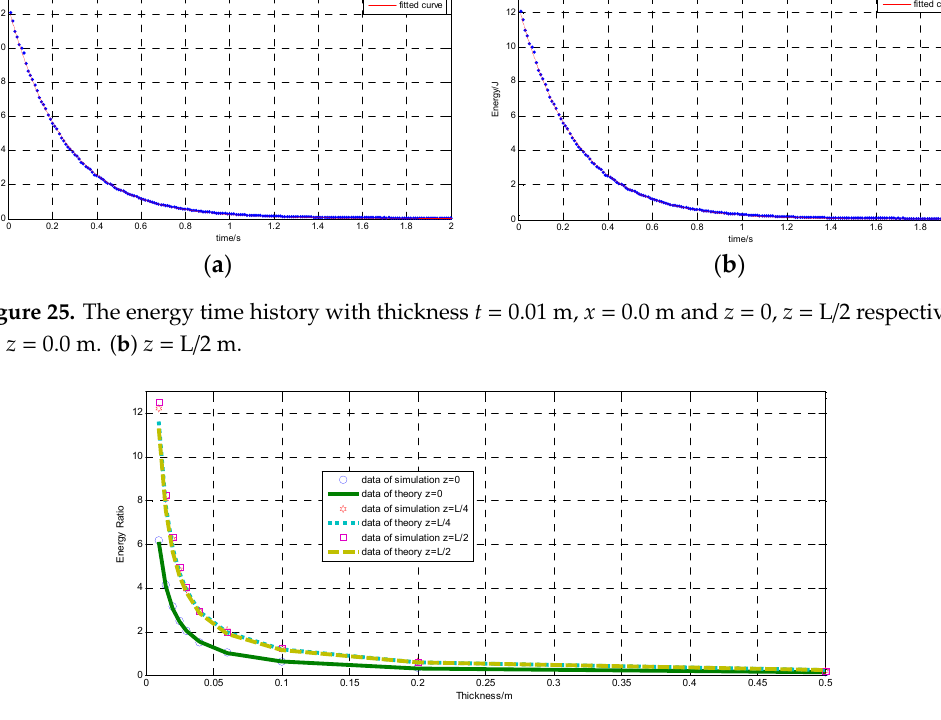
Figure 26. The plot of the ratio vs. thickness when x = 0.